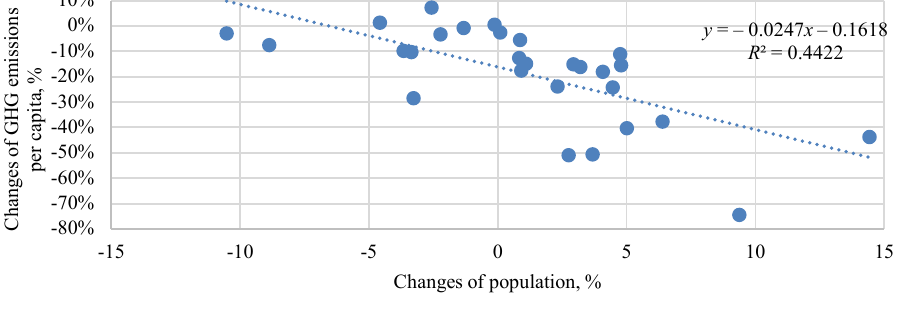
Fig. 3. Changes in GHG emissions in the energy sector relative to population